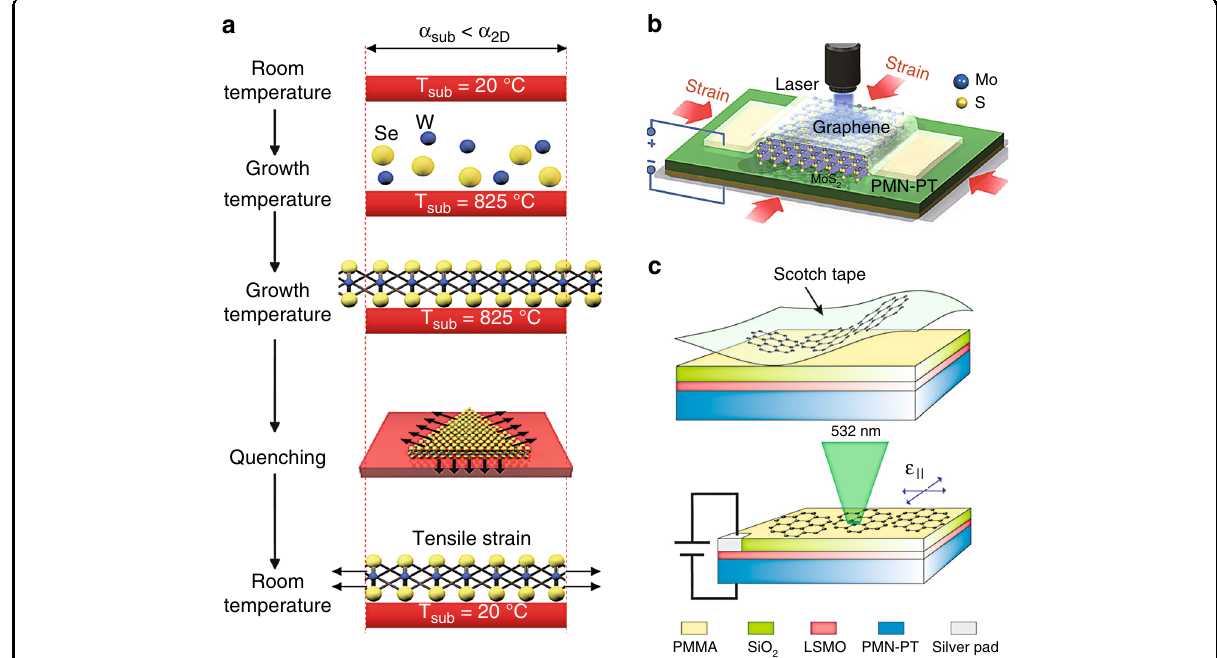
Fig. 8 Thermal expansion and piezoelectric effect for generating homogeneous biaxial strain. a Schematic of the differential thermal expansion induced homogeneous biaxial tensile strain in monolayer WSe 2 , whose thermal expansion coef fi cient is larger than that of the substrate 121 . b Schematic diagram of MoS 2 sandwiched between a piezoelectric PMN-PT substrate and a graphene layer serving as an electrode 76 . c Schematics of scotch-tape-exfoliated graphene on a PMN-PT substrate (upper panel) and an electromechanical device applying an in-plane biaxial strain to graphene (lower panel) 97 . Reprinted a with permission from ref. 121 . Copyright (2017) Springer Nature. Reprinted b with permission from ref. 76 . Copyright (2013) American Chemical Society. Reprinted c with permission from ref. 97 . Copyright (2010) American Chemical